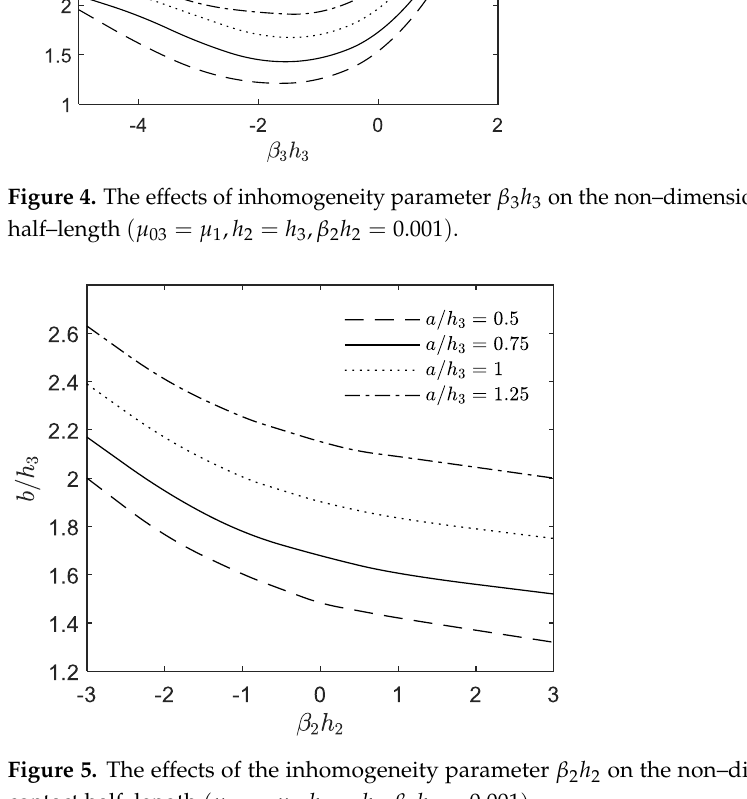
Figure 5. The effects of the inhomogeneity parameter β 2 h 2 on the non–dimensionalized receding contact half–length ( µ 03 = µ 1 , h 2 = h 3 , β 2 h 2 = 0.001 )